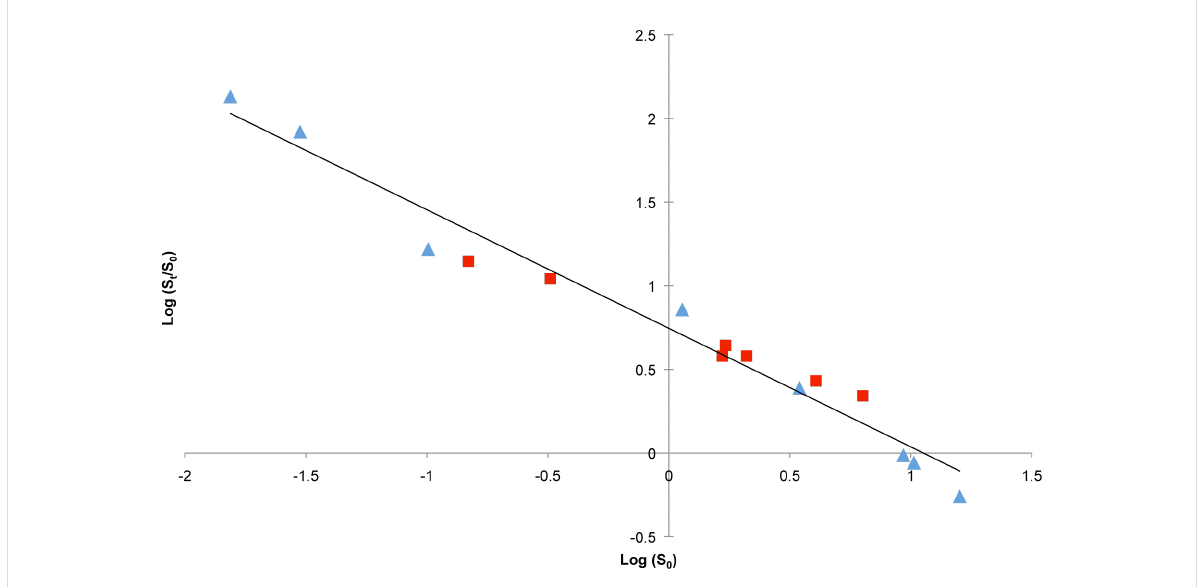
Figure 3: Solubility enhancement (log ( S t / S 0 )) as a function of the solubility (log ( S 0 )) of studied phenylpropanoids (red squares) and monoterpenoids (blue triangles) [32].